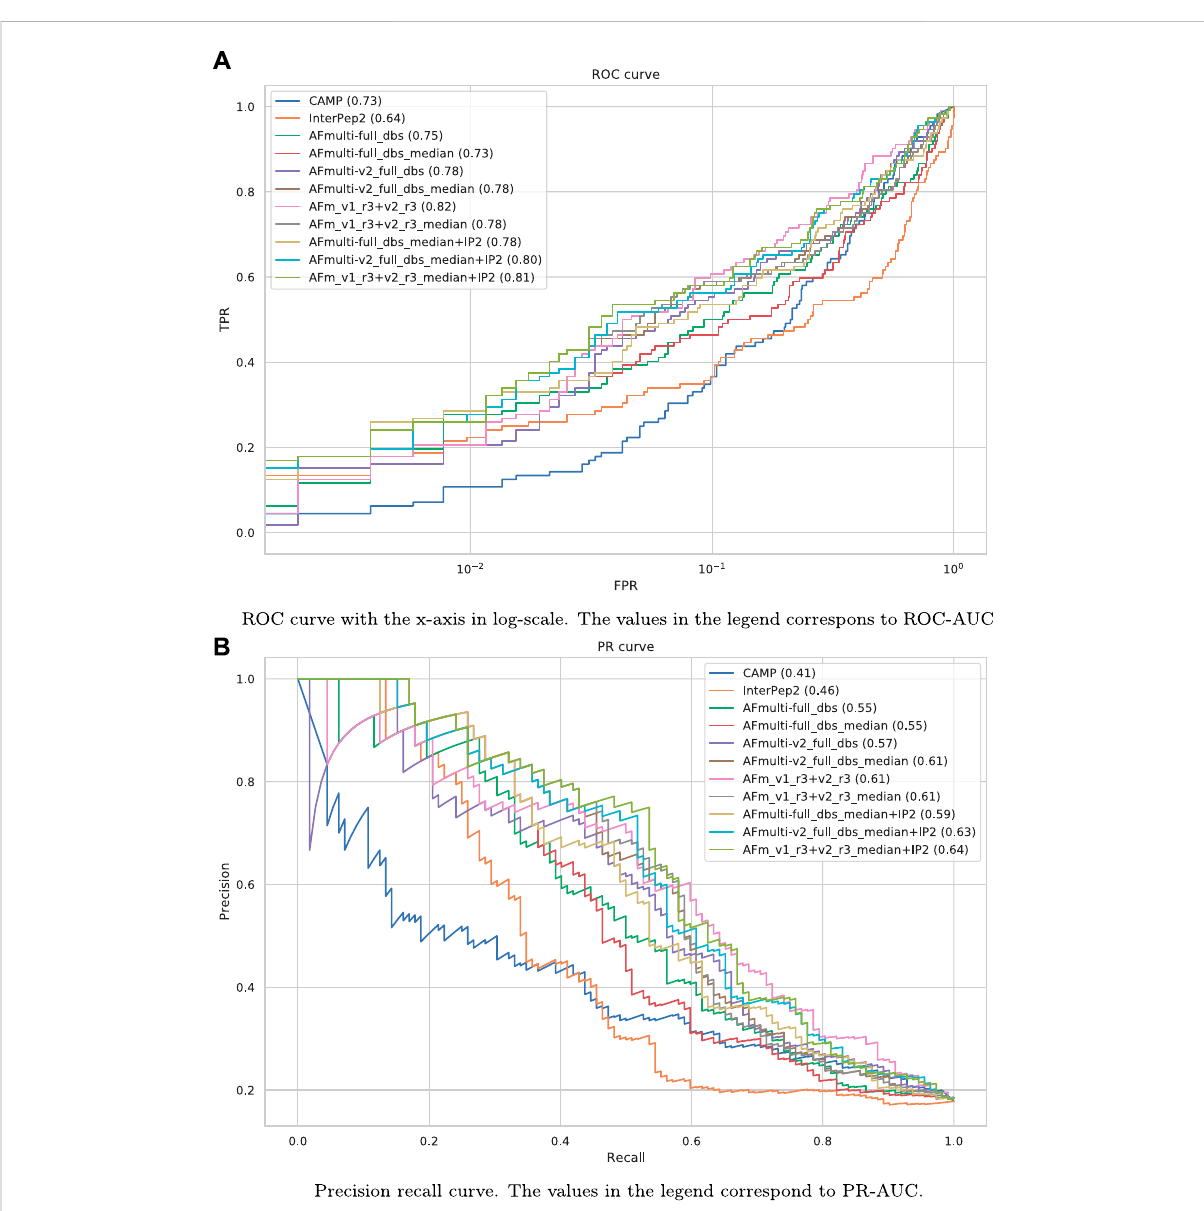
FIGURE 9 Performance measures for peptide-protein interaction prediction. (A) ROC curve with the x -axis in log-scale. The values in the legend correspond to ROC-AUC. (B) Precision recall curve. The values in the legend correspond to